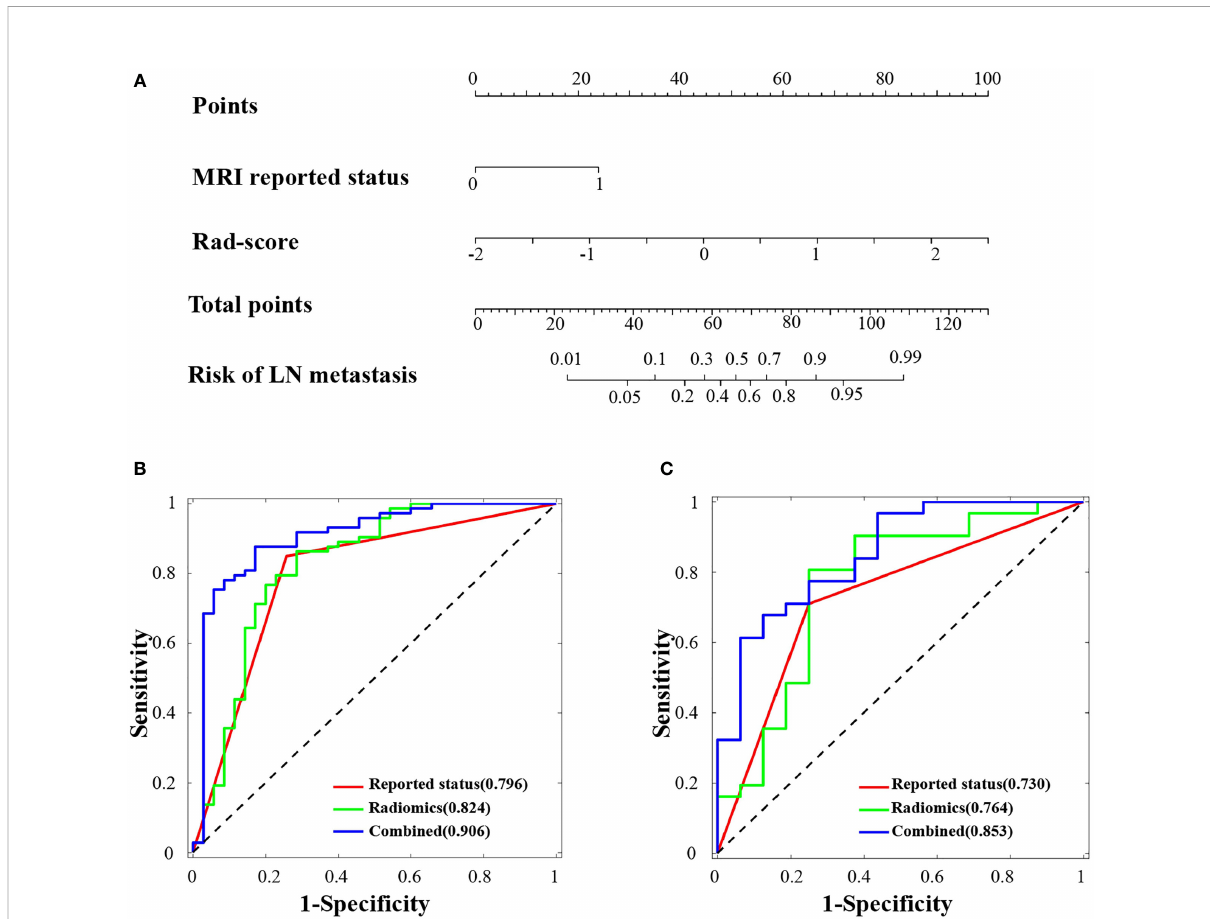
FIGURE 4 Radiomics nomogram developed and receiver operating characteristic (ROC) curves. (A) The radiomics nomogram was developed in the training cohort, with the rad-score and MRI-reported lymph node status incorporated. ROC curves of the combined model (blue lines), radiomics model (green lines) and reported status model (red lines) in the training cohort (B) and validation cohort (C)